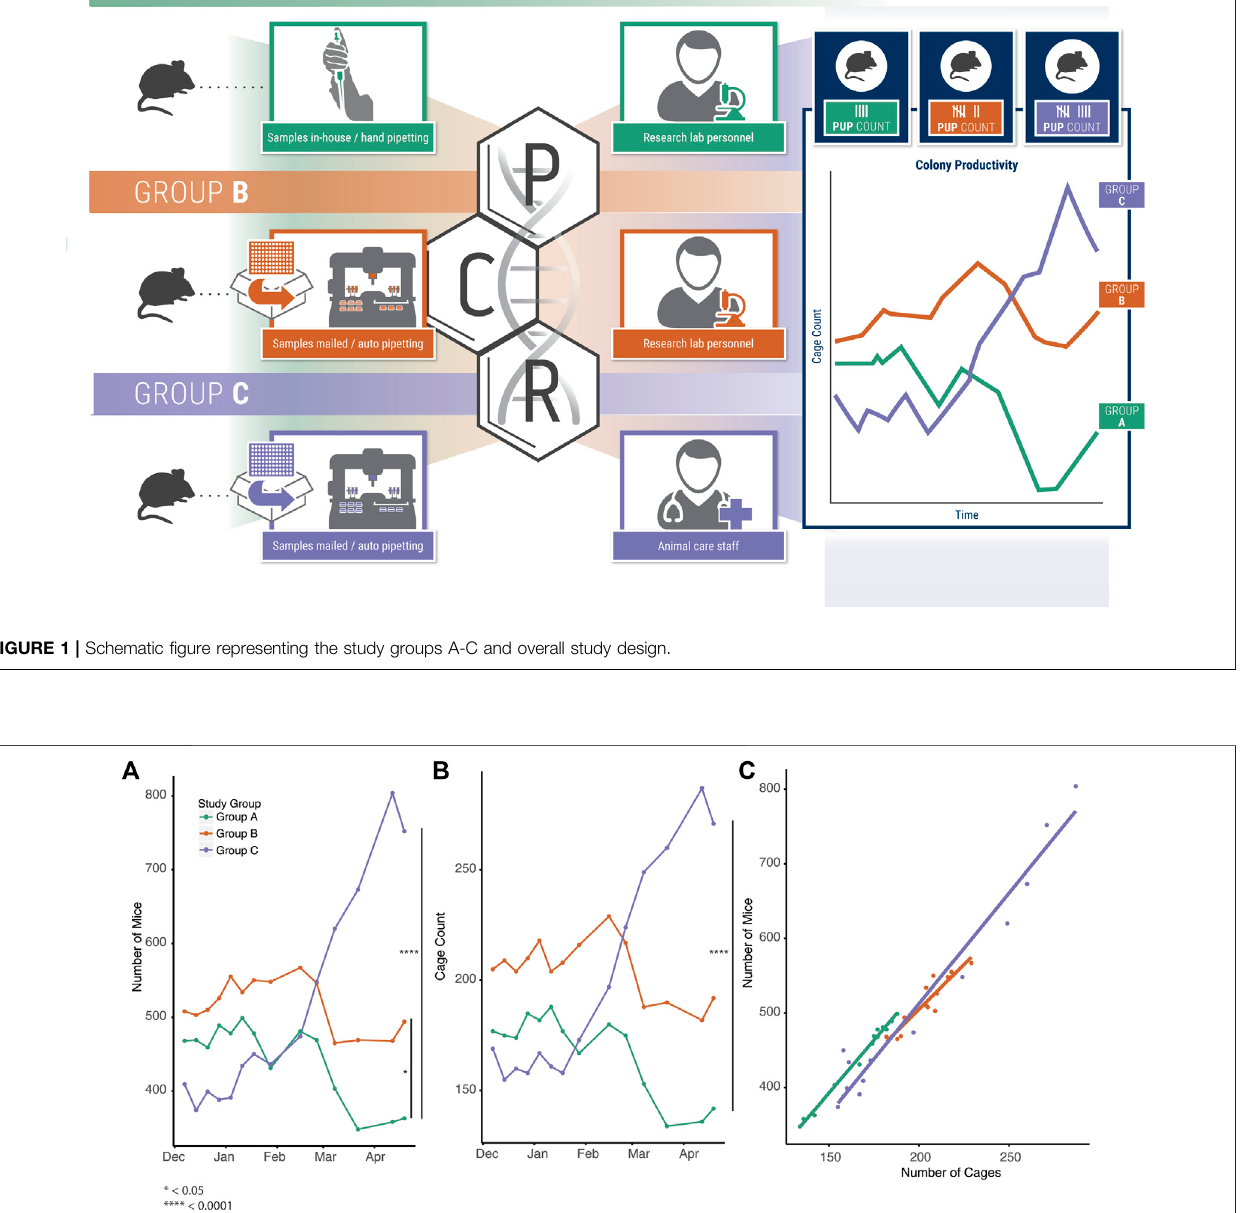
Frontiers in Physiology |